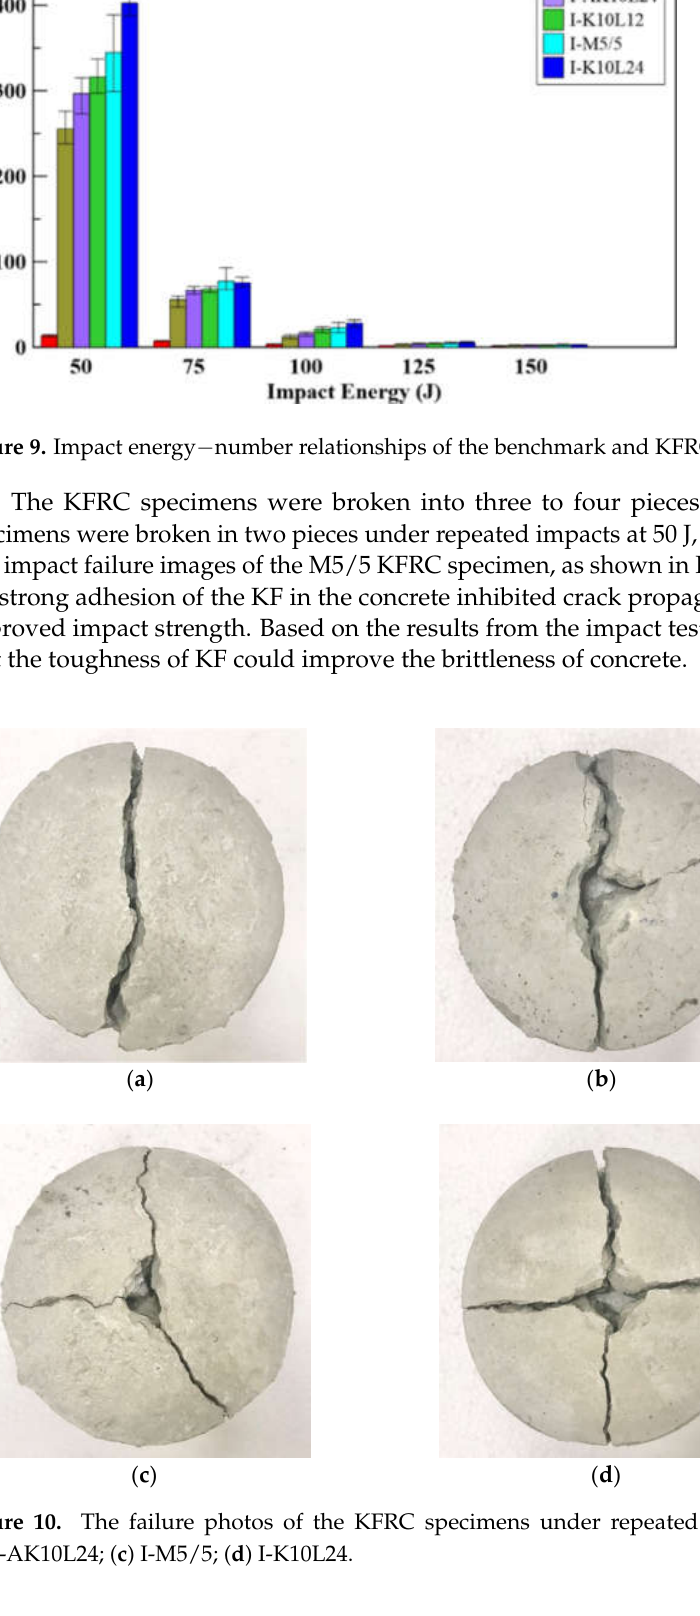
Figure 11. Impact failure images of the I-M5/5 mix-proportion KFRC specimen by using a digital optical microscope. 4.5. Shock Wave Explosion Test Validation As discussed above, the I-K10L24 KFRC specimen presented the highest impact re- sistance and static mechanical properties; therefore, this section used the KFRC slabs (50 cm × 50 cm × 15 cm) with a 10‰ weight ratio of 24 mm original KF to cement for the shock wave test. When dynamite exploded, shock waves carried tremendous energy transmit- ting to RC and KFRC slabs. Explosion damage tended to manifest as cratering on the front face and spalling on the rear face. In the following, SW-B was the benchmark RC slab (without KF), SW-K10L24 was the rebar-reinforced KFRC slab, and SW-K10L24-A was the rebar-reinforced KFRC slab with KFRP (two layers of KF sheets in perpendicular direc- tions) attached to the bottom (rear surface). A contact explosion is the most extreme form of near-field explosion, and localized failure types were expected. The shock wave test results showed that the failure type of the slabs was observed from the post-photographs of the specimens, as shown in Figure 12.